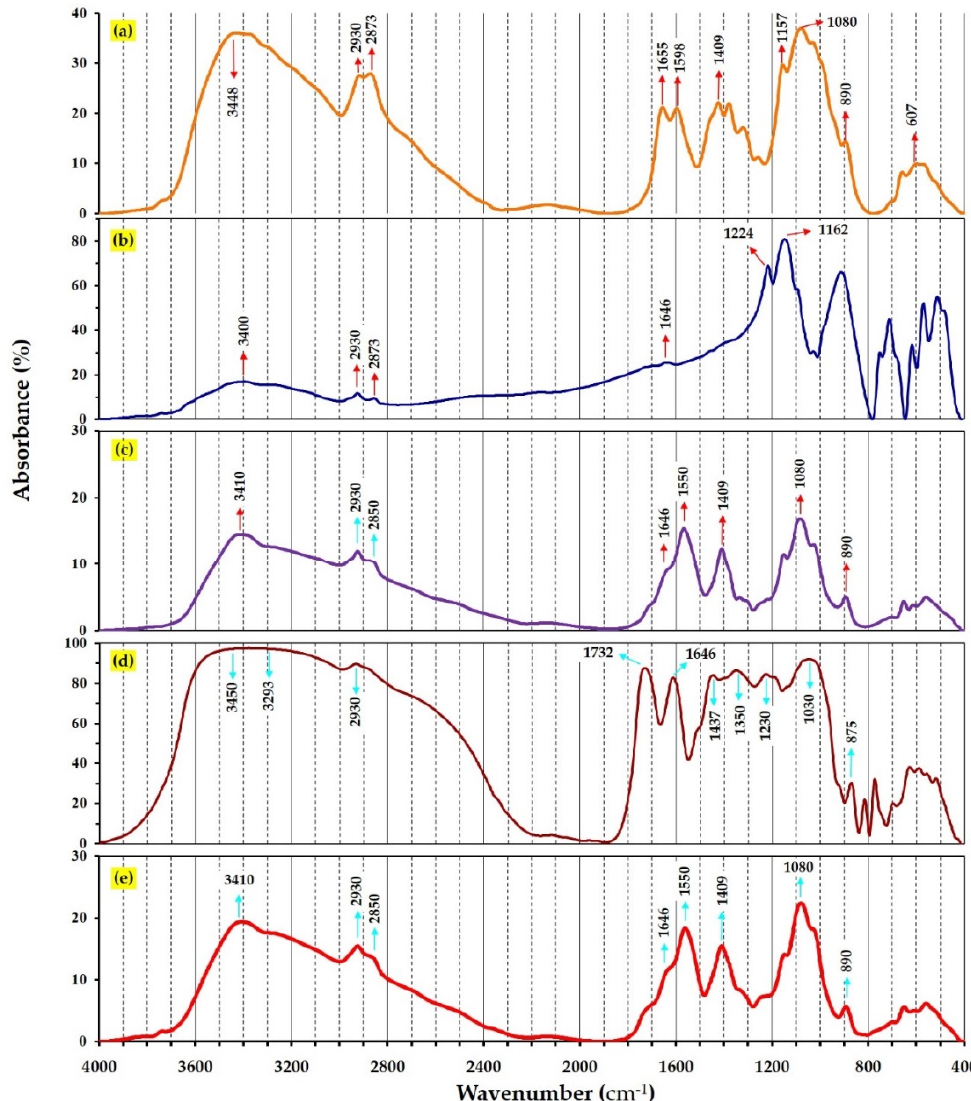
Figure 4. FT-IR spectra of ( a ) chitosan, ( b ) STPP, ( c ) empty CSNPs, ( d ) PPE and ( e ) PPE-loaded CSNPs (at chitosan:PPE ratio of 1:0.50 w/w ).